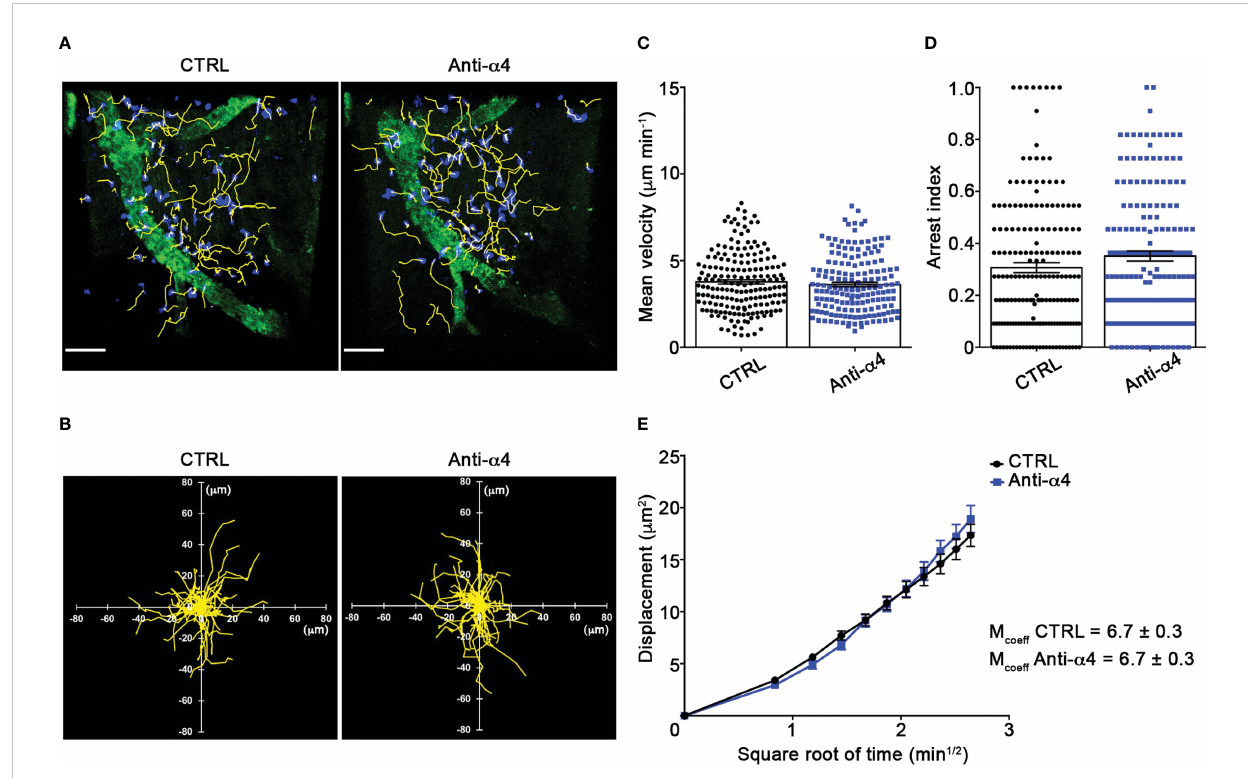
FIGURE 5 a 4 integrins do not affect Th1 cells motility behavior in the spinal SAS at EAE peak. In vitro differentiated Th1 cells were fl uorescently labeled and intravenously injected at disease onset. TPLSM imaging was performed after 48 h, when mice reached the disease peak. (A) Representative images of Th1 cells moving in the spinal SAS before (CTRL) and after 30 min of anti- a 4 integrin treatment (anti- a 4 antibody) (scale bar = 50 µm). (B) Normalized trajectories of 70 Th1 cells over 12 time points before and after anti- a 4 antibody. (C) Mean velocity and (D) arrest index of Th1 cells before and after a 4 integrins blockade. Statistical signi fi cance was calculated using the Mann – Whitney test. (E) Mean displacement of Th1 cells in not affected by anti- a 4 blocking antibodies (After linear regression application, the differences between slopes resulted not quite signi fi cant; P = 0.0884). All data are expressed as mean ± SEM. A total of 185 cells were analyzed for CTRL and 171 after anti- a 4 treatment from two independent experiments. Track lower than 12 time points were excluded from the